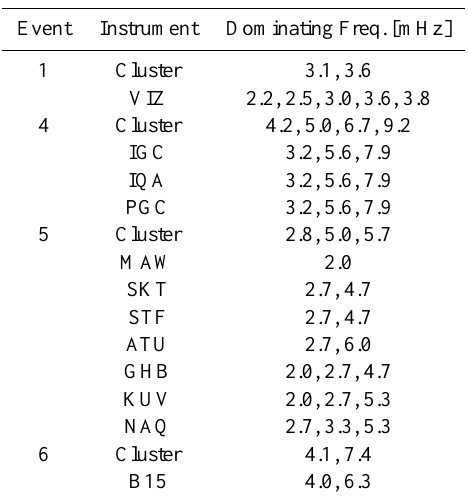
Table 11. Comparison between the dominating frequencies in Clus- ter and SuperMAG magnetic field data. The dominating frequencies are those which had the higher PSD when compared to the sur- rounding frequencies.